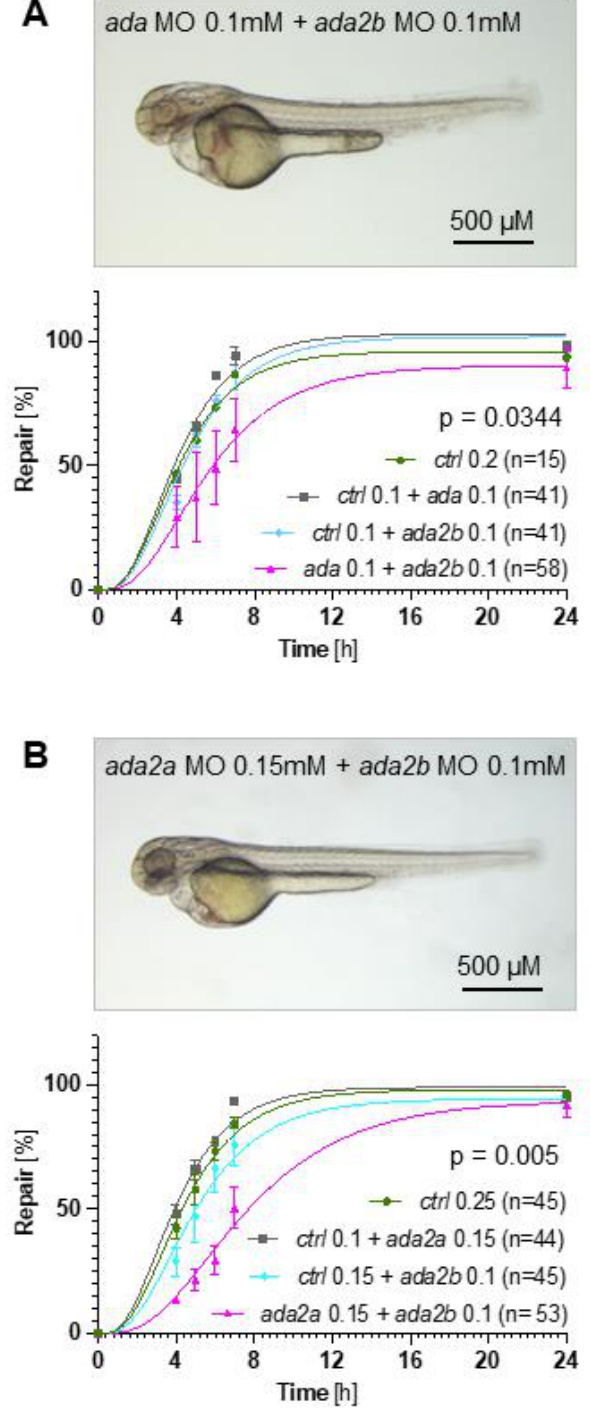
Figure 3. Synergistic effects between adenosine deaminase family members. ( A ) Combining low concentrations of the ada splice-blocking morpholino oligonucleotide (MO) and the ada2b translation-blocking MO did not affect zebrafish embryogenesis. However, the combination significantly delayed the repair process in comparison to the control ( ctrl ) or either single MO. ( B ) Combining low concentrations of the ada2a translation-blocking MO and the ada2b translation-blocking MO did not affect zebrafish embryogenesis. However, the combination significantly delayed the repair process in comparison to the control ( ctrl ) or either single MO (mean ± SEM; 2-way ANOVA). 2.3. The ATP-Sensing Purinergic P2RY2 Receptor Is Required for a Normal Migratory Response after Pronephros Injury Single-cell RNA sequencing revealed expression of zebrafish p2ry2 along the entire pronephros [21], while members of the p2x and other members of the p2y gene family were expressed at lower levels (Figure 4A). Three different genes encode for zebrafish p2ry2 ( p2ry2 .1, p2ry2.2 , and p2ry2.3 ). All three p2ry2 genes were upregulated in response to injury (Figure 4B – D). The combined knockdown, using three different TBMs, resulted